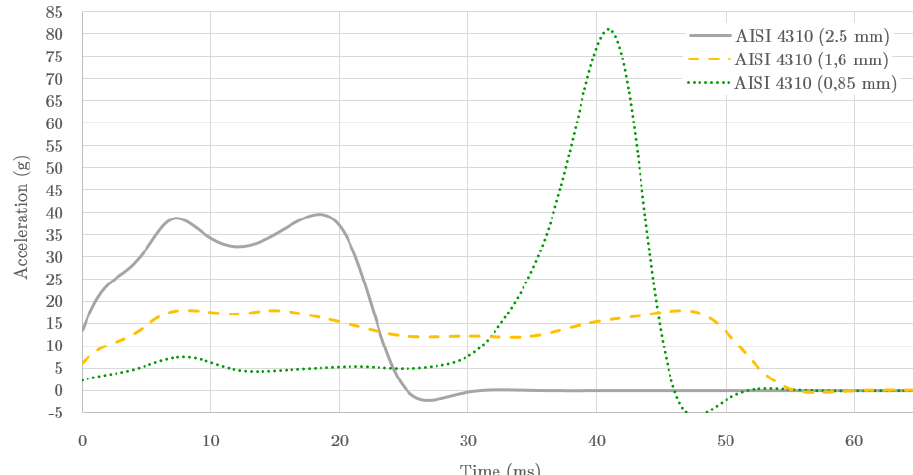
Figure 7. Acceleration(g) as function of the time (ms) during the impact. The data corresponds to the FE model applied to steel AISI-4310. The different results correspond to plates with thicknesses 2.5 mm (solid line), 1.6 mm (dashed line) and 0.85 mm (dotted line). The model represented is that with reduced integration of the shell IA mesh elements.